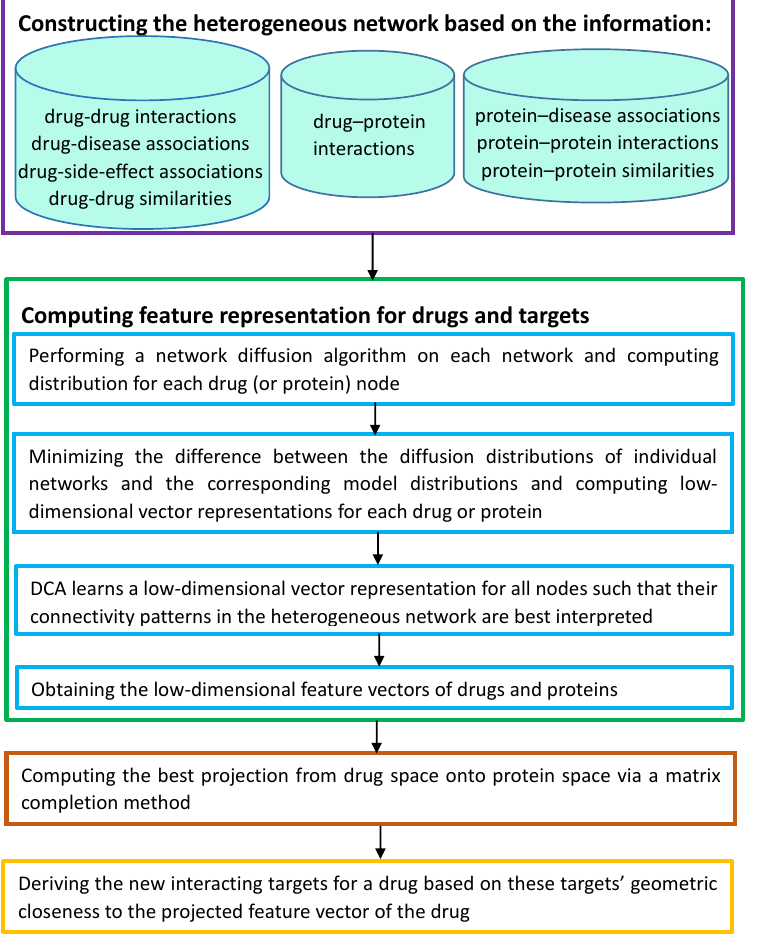
Figure 4. The flowchart of a novel Network integration pipeline for DTI prediction